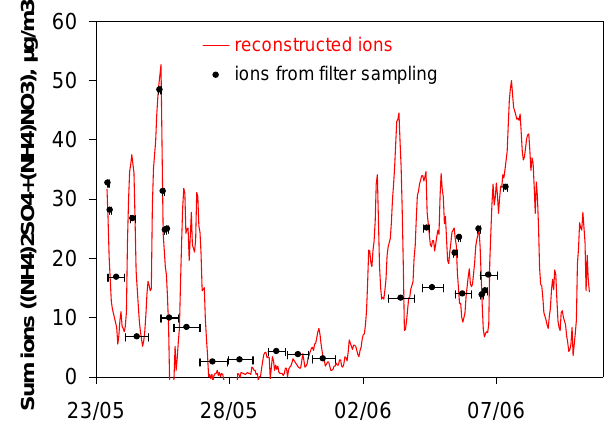
Fig. 1. Hourly OC concentrations from the semi-continuous OCEC sunset field instrument (uncorrected for the offset of 3.03µgCm − 3 ) and OC concentrations from the manual filter sampling. Horizontal bars stand for the duration of the filter sampling.